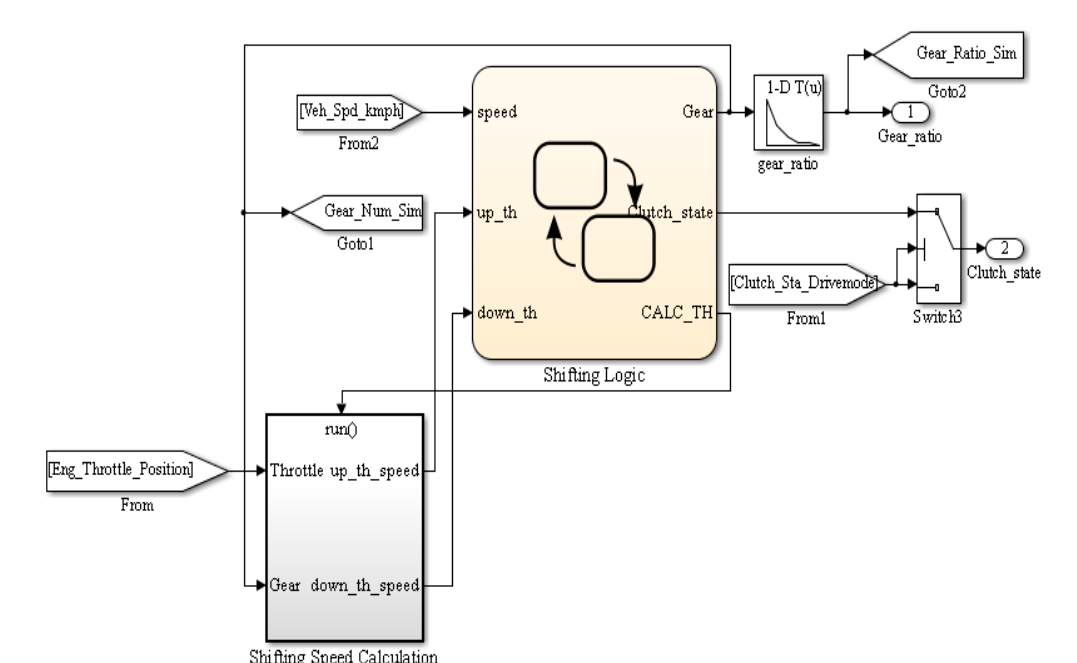
Figure 6. Gear shift model of the automated mechanical transmission (AMT) gearbox.